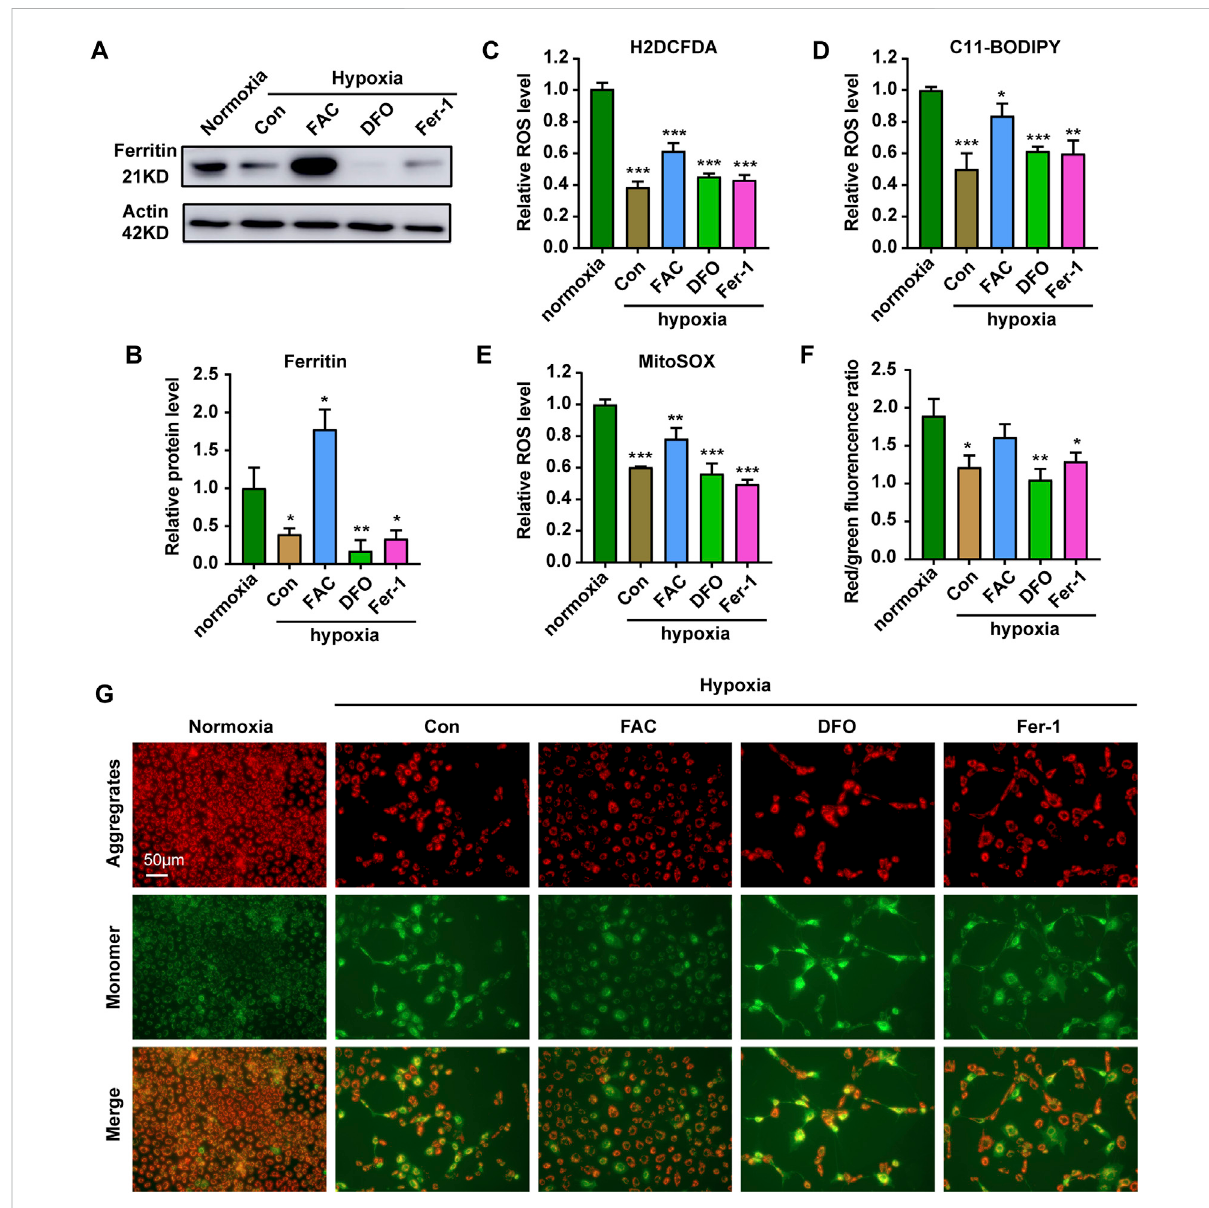
FIGURE 3 Iron supplementation can increase ROS level and reduce mitochondrial damage in cells under hypoxia stress. (A,B) Western blot analysis and quanti fi cation of Ferritin expression in ZFL cells cultured under normoxia and hypoxia treated with FAC, DFO and Fer-1 for 3 days. Actin as a loading control. (C – E) Analysisofchanges intotalROS (C) , lipidperoxidation level (D) and mitochondrial-derived ROS (E) levels incells with H2DCFDA, C11- BODIPY and MitoSOX probe under normoxia and hypoxia for 3 days. Cells under hypoxic stress were rescued with FAC (2.5 mM), DFO (10 µM) and Fer-1 (2.5 µM). (F,G) Quantitative results and representative images of cellular JC-1 fl uorescence in normoxic cell and hypoxic cells treated with FAC (2.5 mM), DFO (10 µM) and Fer-1 (2.5 µM) under hypoxia stress. Normoxia was used as a control group for signi fi cance analysis. Error bars, mean ± s.d., n = 3 (biological